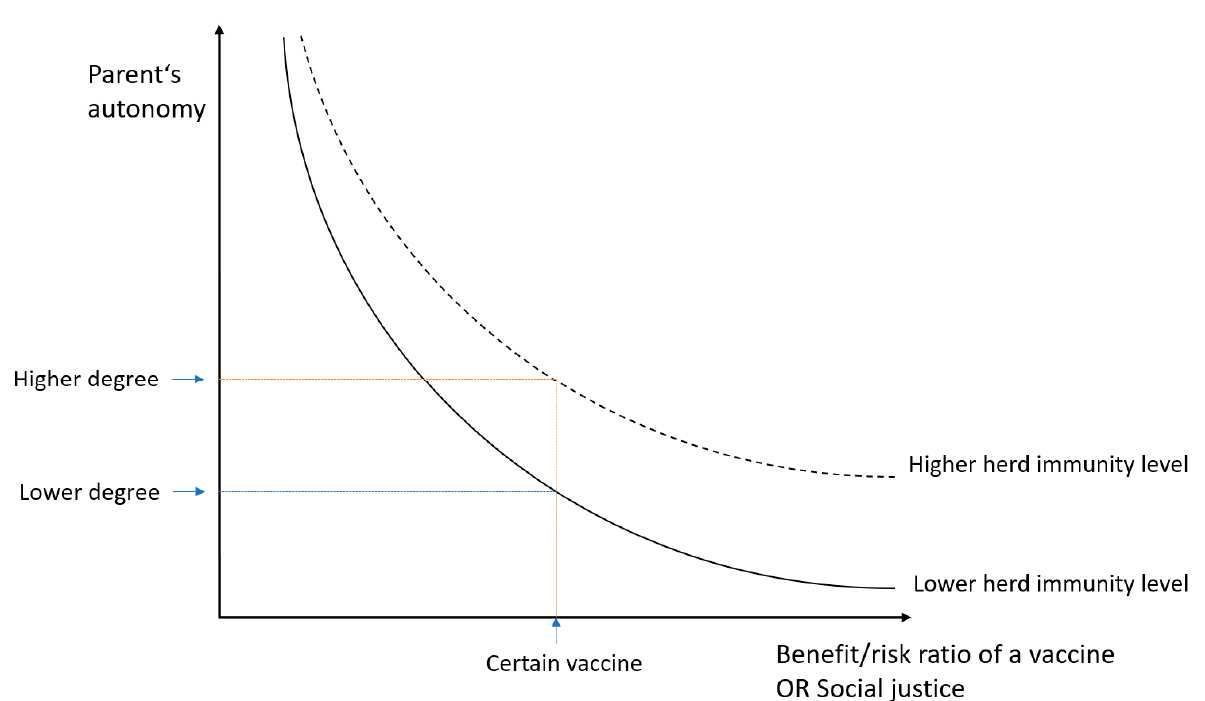
Figure 1. Relation between parents’ autonomy and benefit:risk ratio of a vaccine (or social justice). The curve can be moved upwards in case of a good society immunisation level, which could allow a higher degree of parents’ autonomy and non-medical exemptions from vaccination.